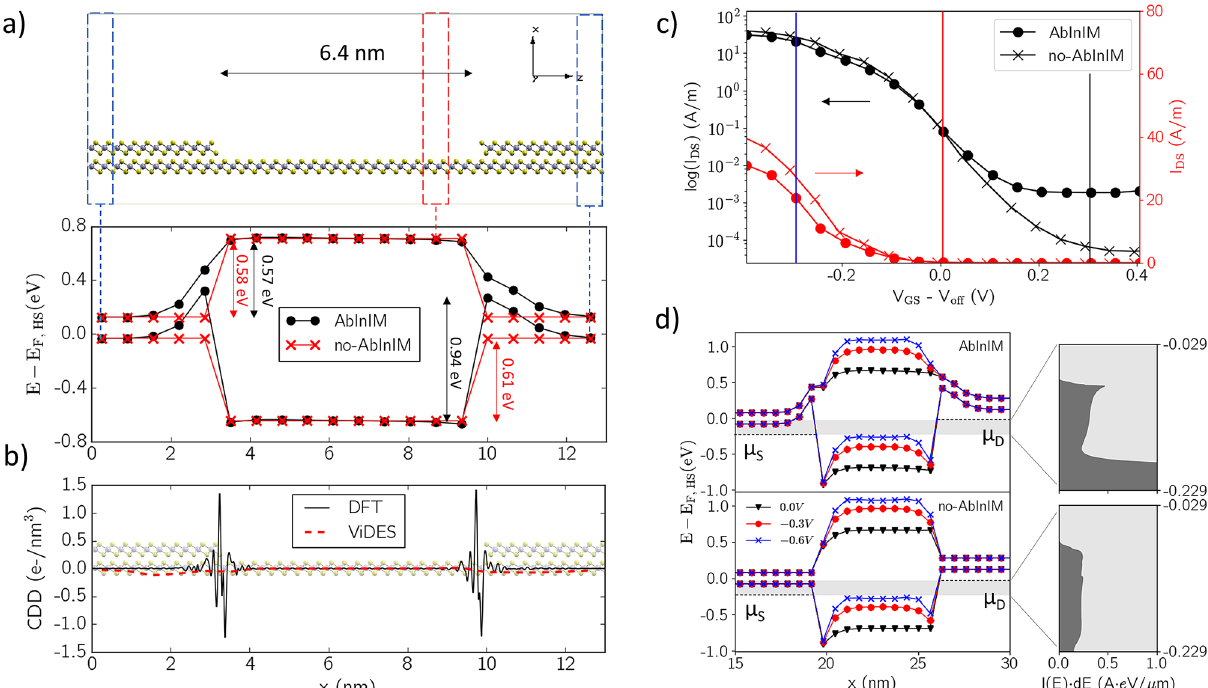
Figure 4. Charge transport with and without mapping E on-site from DFT. ( a ) Top: supercell used to model the 2L-1L LH of PtSe 2 . Bottom: Conduction and valence band edges across the LH, obtained mapping (black) the full DFT potential or simply aligning according to 1L and 2L PtSe 2 electron affinity (red). The barrier heights for electrons and holes are highlighted. ( b ) Charge density difference, averaged over yz planes, from DFT (black solid) and from self-consistent NEGF-electrostatics simulations (red dashed). The DFT supercell is also shown in background. ( c ) Current–voltage characteristics for the PtSe 2 LH-FET at V DS = -0.2 V in linear (red) and semi-logarithmic (black) scale, with V off = -0.306 V (-0.294 V) for the “AbInIM” (“no-AbInIM”) case. d) Band diagrams at V GS = 0.0 V, -0.3 V and -0.6 V, indicated with vertical lines in panel ( c ), for the two approaches. Panels on the right side show the spectral current within the bias window in the two cases, at V GS = 0.0 V. This figure was made using VMD [v1.9.1, https:// www. ks. uiuc. edu/ Resea rch/ vmd/ vmd-1. 9.1] and Matplotlib [v3.3.3, https:// doi. org/ 10. 5281/ zenodo. 42689